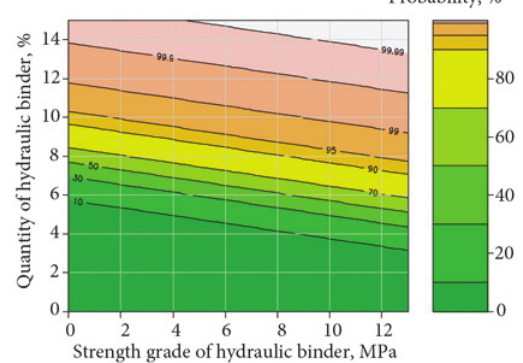
Fig. 5. Contour map of probability of conformity of the compressive strength condition by a soil-binder mixture made from soil No. 1 tested after 90 days (2.5 MPa ≤ R c 42 ≤ 5.0 MPa), without consideration of the frost resistance coefficient n ( n =